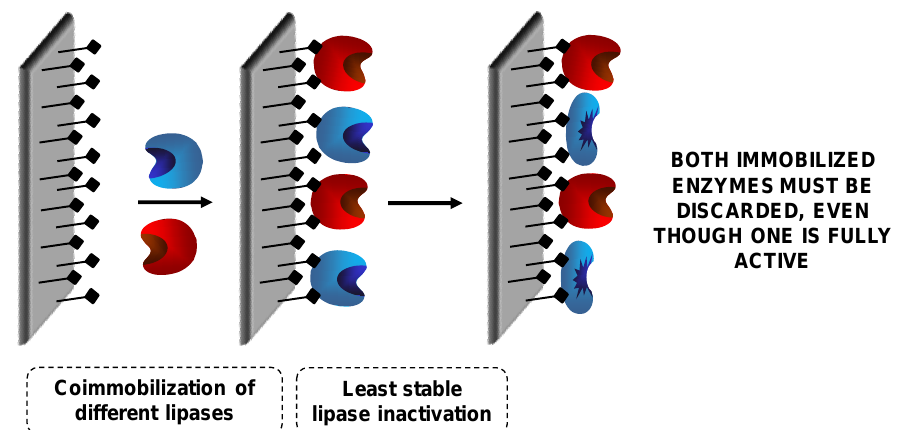
Figure 24. The problem of covalently coimmobilizing enzymes with different stabilities: both immobilized enzymes must be discarded when the least stable enzyme is inactivated.